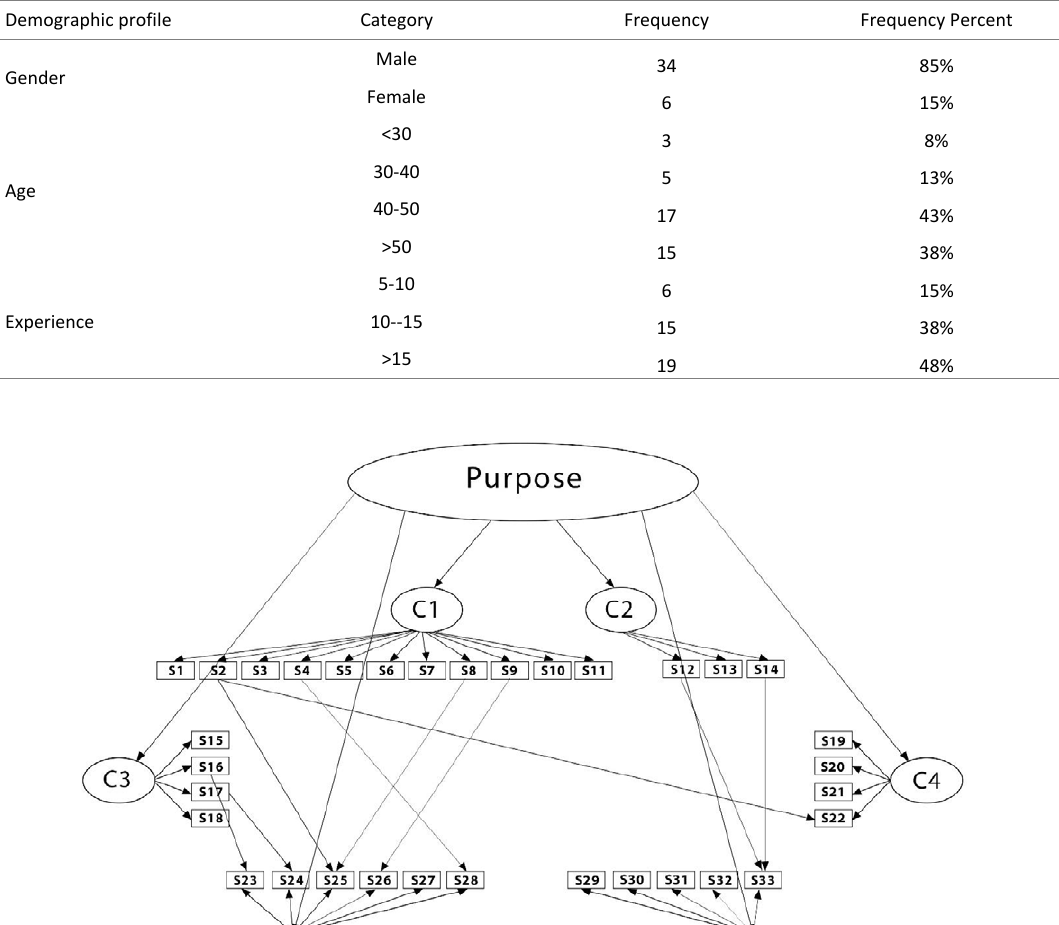
Table 4. Sample demographic characteristics